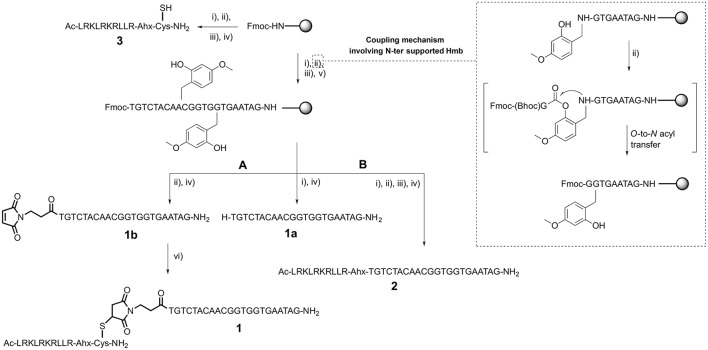
CPP-PNA synthesis: (A) thiol-maleimide addition and (B) direct solid-phase synthesis. (i) Piperidine, DMF; (ii) Fmoc-AA-OH/Fmoc-PNA monomer, HATU, DIEA, lutidine, NMP or maleimido-propionic acid, DIC, HOBt, DMF for 1b; (iii) Ac2O, lutidine, DMF; (iv) TFA, TIS, H2O for 1a, 1b, and 2 or TFA, DODT, TIS, H2O for 3; (v) Hmb-CHO, AcOH, DMF then NaBH3CN, DMF; (vi) 3 and 1b dissolved in PBS then pH was raised to 7.4–7.6 using NH4OH solution pH 8.